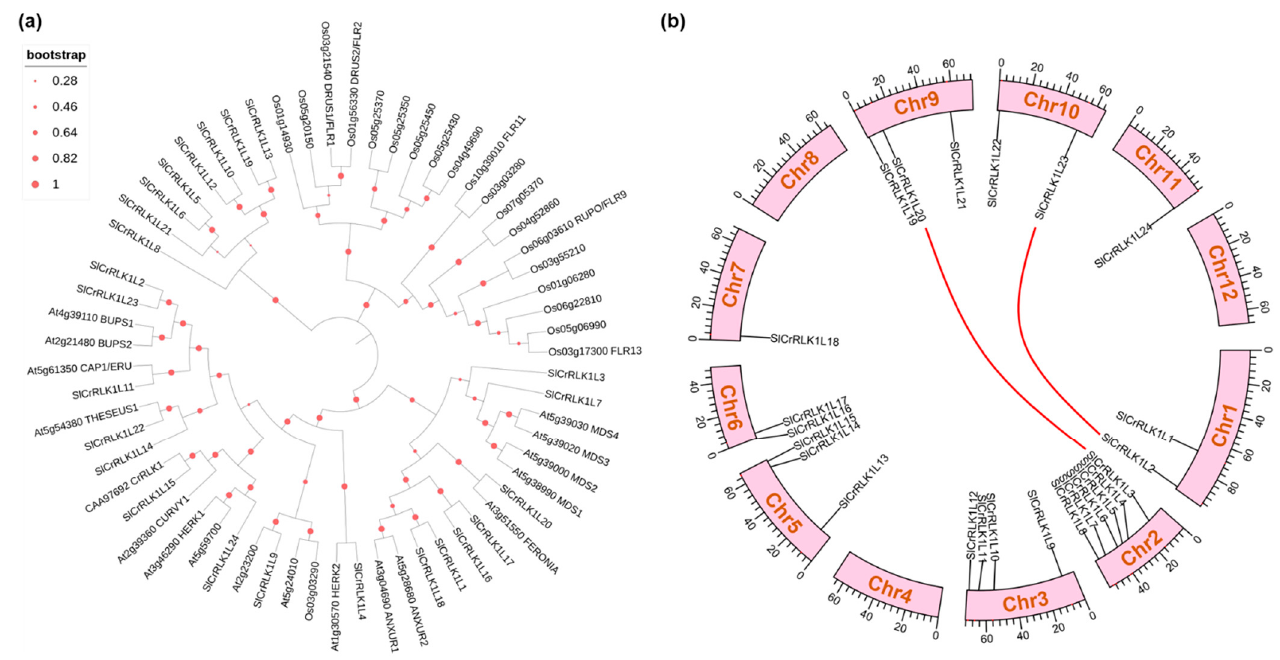
Figure 3. Evolutionary analysis of SlCrRLK1Ls. ( a ) Phylogenetic analysis of CrRLK1Ls in tomato, Arabidopsis , rice, and Madagascar periwinkle. ( b ) Chromosome position and collinearity of SlCrRLK1Ls . The collinearity relationship is marked by red lines. Unit: Mb.